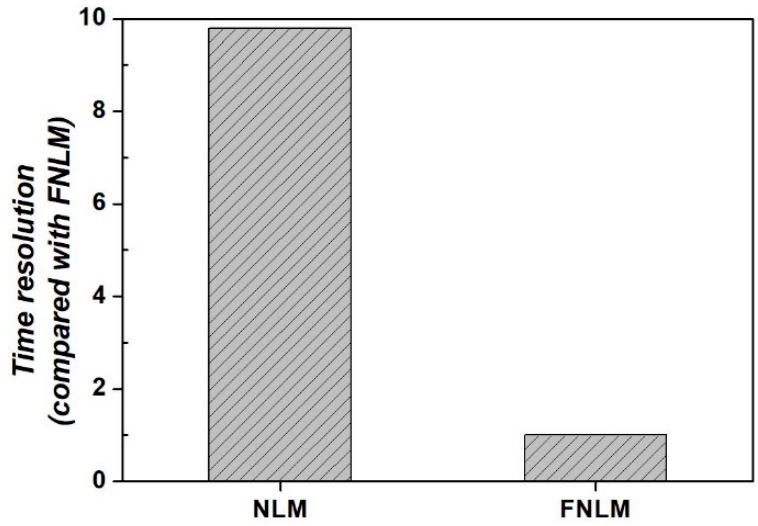
Figure 7. Time resolution results of applying non-local means (NLM) and FNLM algorithms to color LM images.